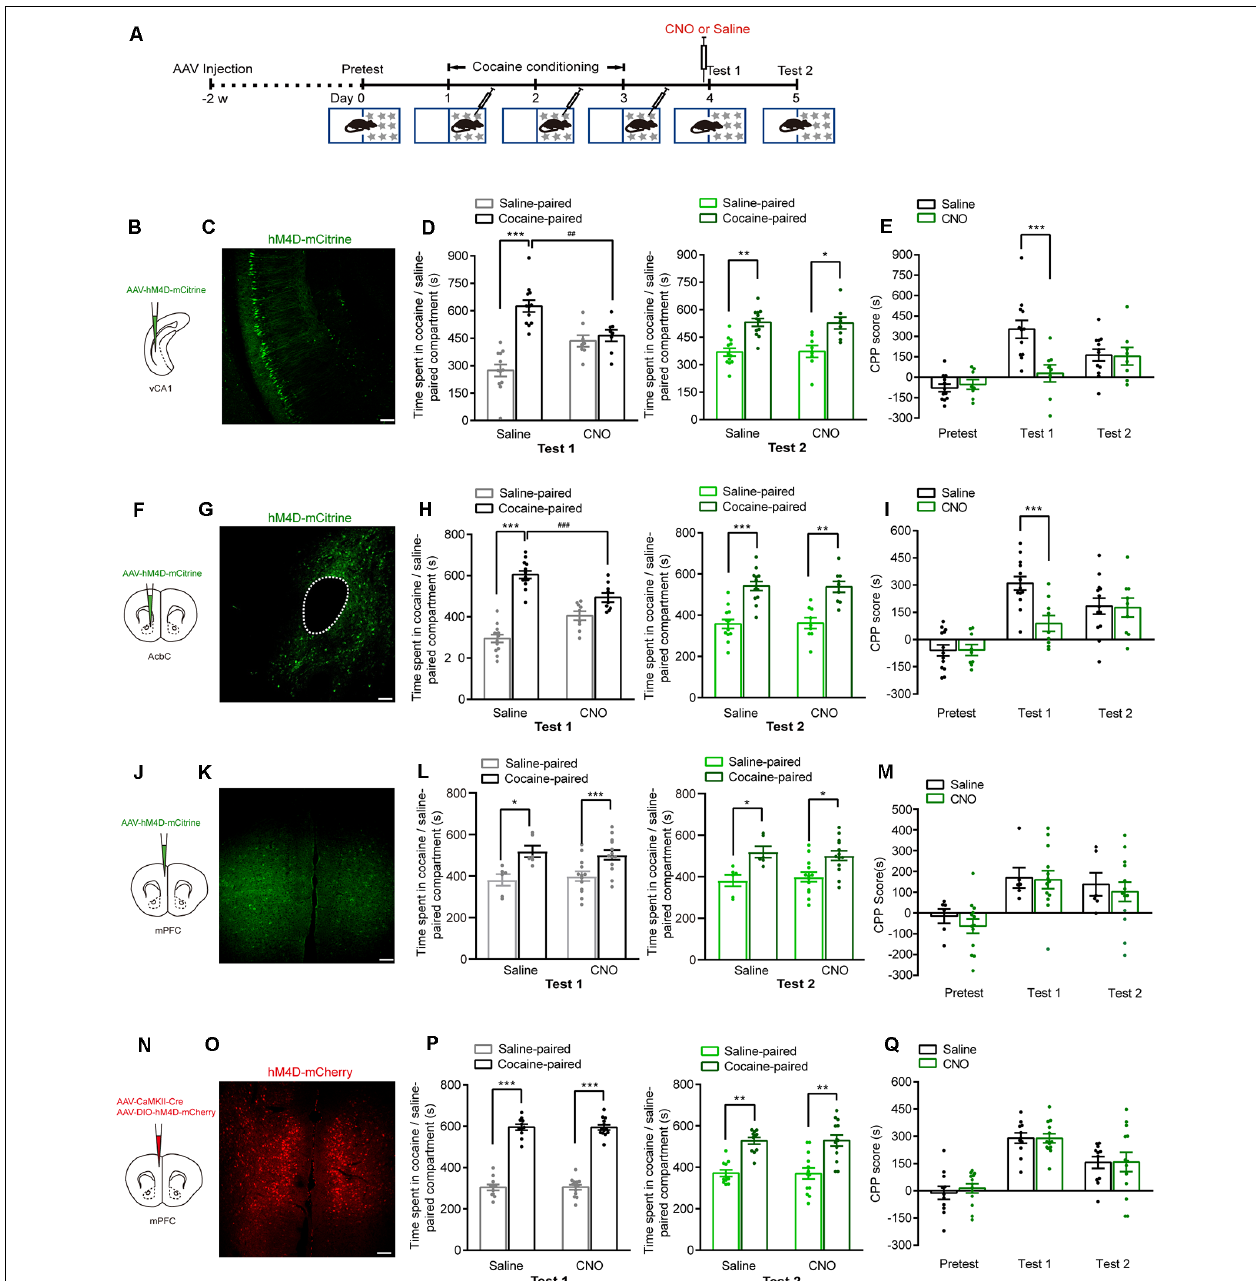
FIGURE 3 | Chemogenetic inhibition of either vCA1 or AcbC neurons suppressed the retrieval of cocaine-CPP memory. (A) Behavioral schedule. AAV-EF1 α -hM4D-mCitrine was injected in the vCA1, AcbC, or mPFC or AAV-CaMKII-Cre and AAV-hSyn-DIO-hM4D-mCherry were injected in the mPFC 2 weeks before CPP training. Saline or Clozapine- N -oxide (CNO; 1 mg/kg, i.p.) was injected 30 min before test 1. (B,F,J,N) Viral injection. (C,G,K,O) Representative images of hM4D-mCitrine or hM4D-mCherry fluorescence in vCA1 (C) , AcbC (G) , and mPFC (K,O) . Scale bar: 100 µ m. (D,H,L,P) Bar graphs representing the time spent in the cocaine-paired and the saline-paired compartments of saline- and CNO-treated groups in the test 1 and test 2 sessions. * P < 0.05, ** P < 0.01, *** P < 0.001 vs. the saline-paired compartment, ## P < 0.01, ### P < 0.001 vs. the saline group. (E,I,M,Q) Bar graphs showing the CPP scores of saline- and CNO-treated groups. *** P < 0.001 vs. saline group (vCA1: saline n = 12, CNO n = 8; AcbC: saline n = 13, CNO n = 9; mPFC: saline n = 6, CNO n = 13; mPFC: saline n = 11, CNO n = 13).